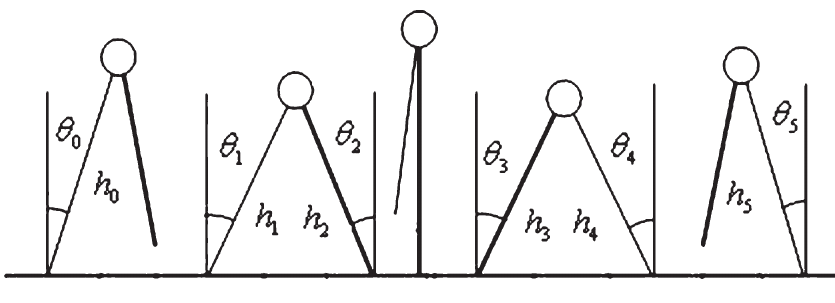
Fig. 2. Gait of a whole walking